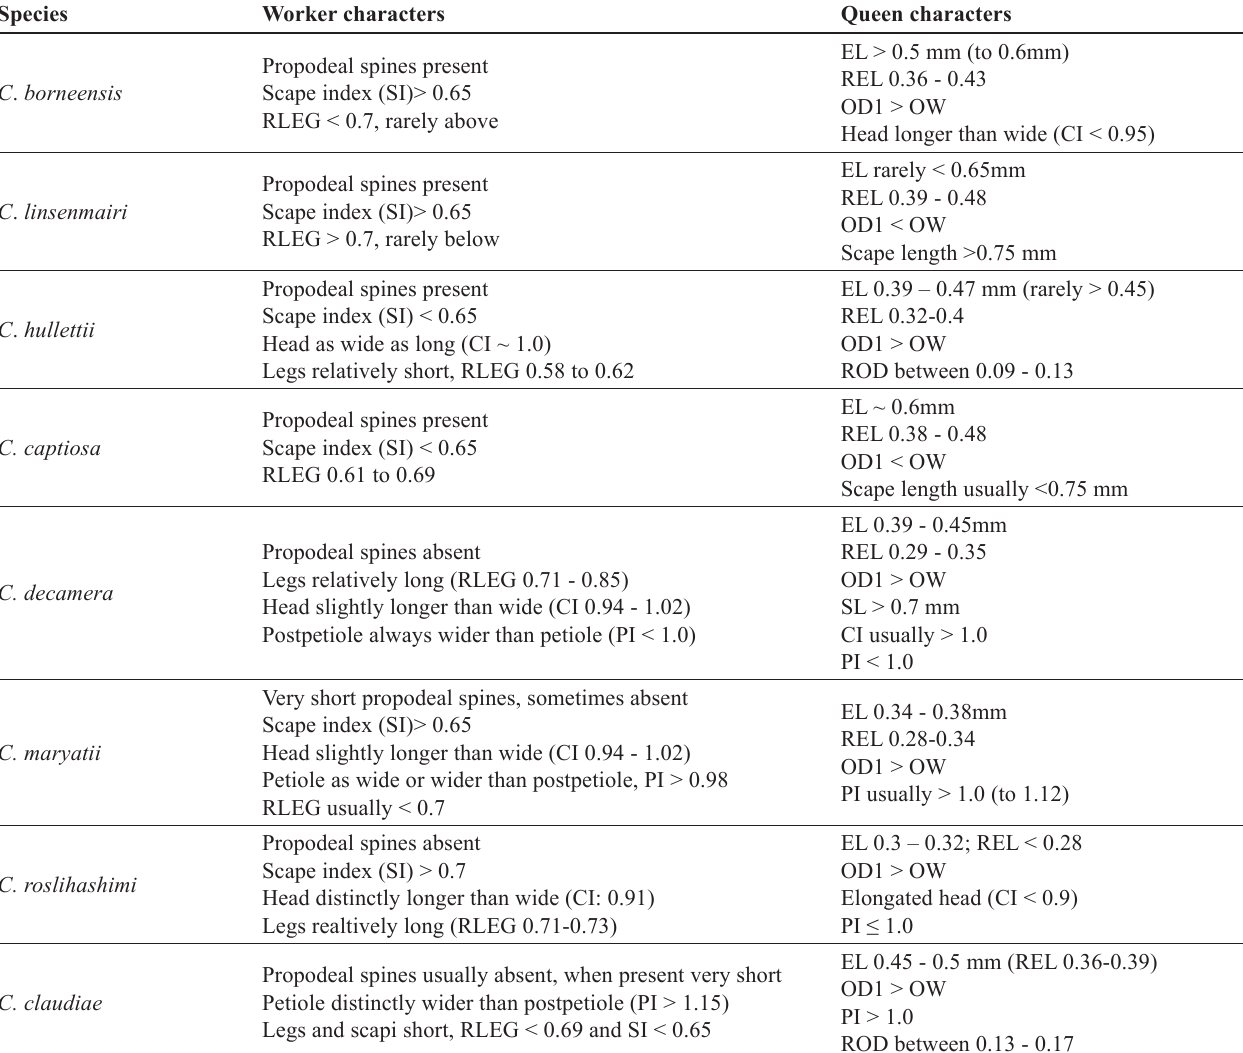
Table 1 . Overview of most distinct morphological characters of the Macaranga -associated Crematogaster ( borneensis -group) species. Species Worker characters Queen